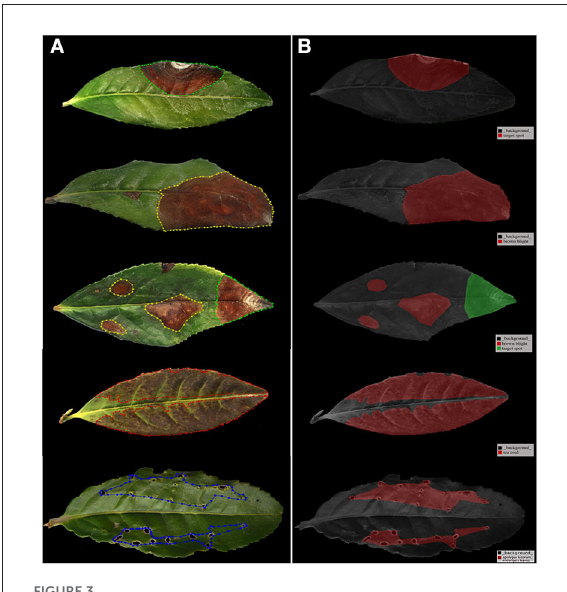
FIGURE3 Labeled images sample. (A) The images in the process of leaves labeling and (B) images after leaves marking.